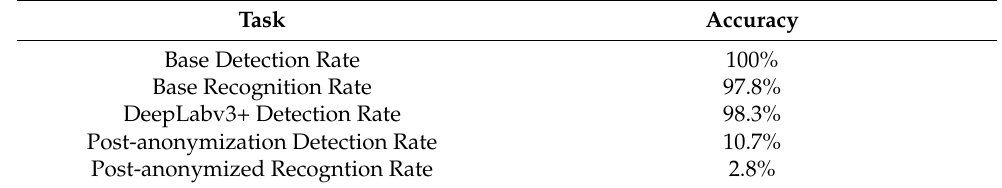
Table 2. Detection and Recognition rates on the 20,000 image CCPD* dataset. Base detection and recognition rates are the performance of the classifier from Zhang and Huang [40]. The DeepLabv3+ detection rate is the percent of the test set where a license plate was detected. Post-anonymization detection and recognition rates are the rates for the classifier from Zhang and Huang [40] on the test dataset after